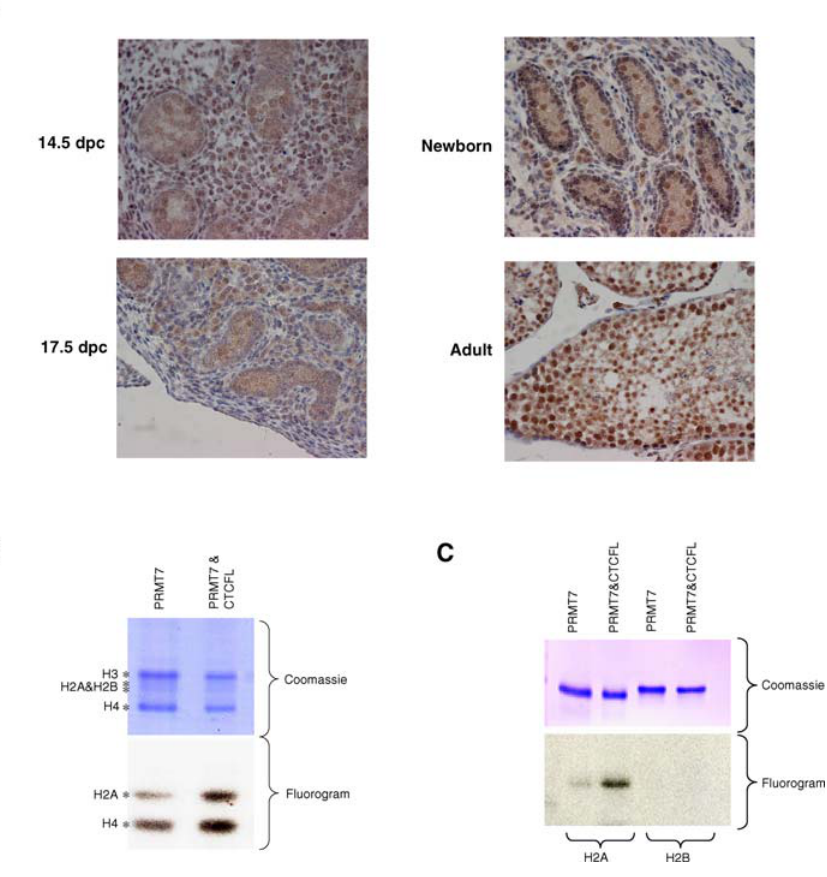
Figure 5. Developmental Expression and Methyltransferase Activity of PRMT7 (A) Developmental expression of PRMT7. Immunohistochemistry with a -PRMT7 on testis at the indicated stages of development. (B) PRMT7 in vitro methyltransferase reactions with total histones were performed either with a -V5–immunopurified PRMT7-V5 or a -V5–co- immunopurified PRMT7-V5&CTCFL-Myc. Upper panel shows Coomassie staining. Lower panel shows fluorogram (7-d exposure). Methylation of histones H2A and H4 is stimulated by co-immunoprecipitating CTCFL. (C) Discrimination between H2A and H2B methylation. For these histone methyltransferase reactions, CTCFL-myc and PRMT7-V5 were immunopurified separately using a -Myc and a -V5 antibodies, respectively, in reactions containing either H2A or H2B. Upper panel shows Coomassie staining. Lower panel shows fluorogram (7-d exposure). Stimulation of histone H2A methylation is observed with the addition of immuno-purified CTCFL. DOI: 10.1371/journal.pbio.0040355.g005